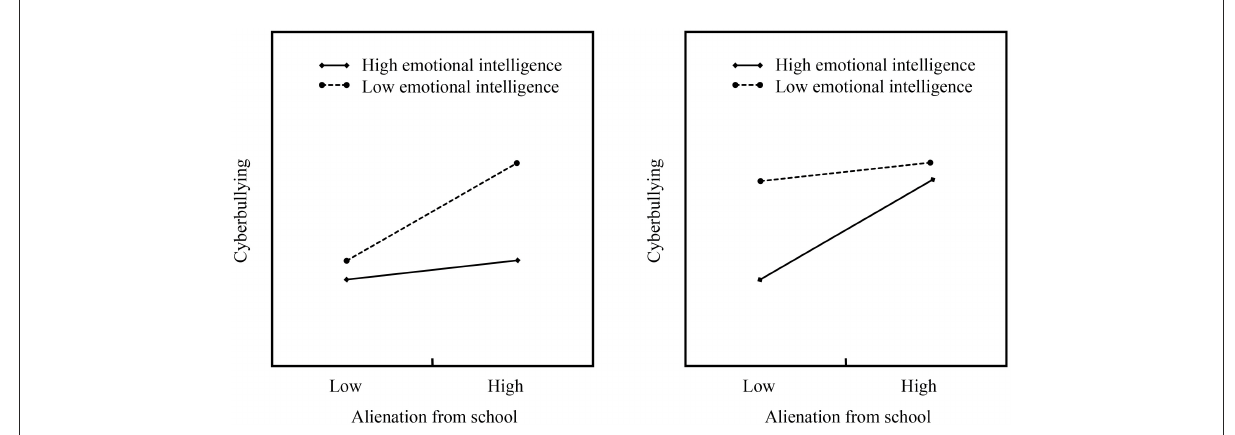
FIGURE1 Hypothetical alienation from school × Emotional intelligence interaction impacts. (A) On the right is the risk-buffering model, and (B) on the left is the reverse risk-buffering model.